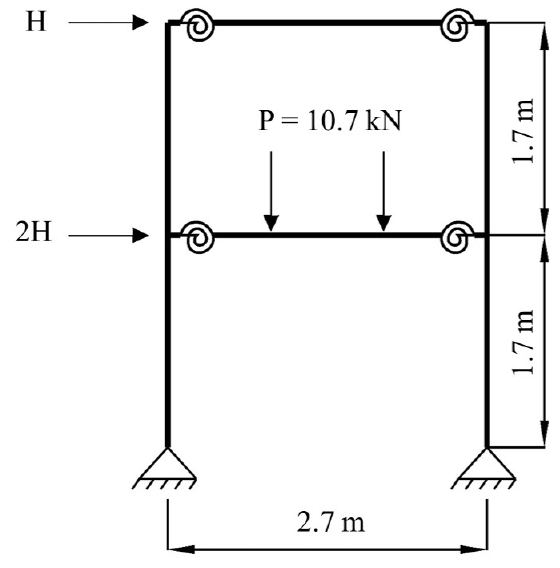
Figure 10. Experimental model by Stelmack et al. [46].